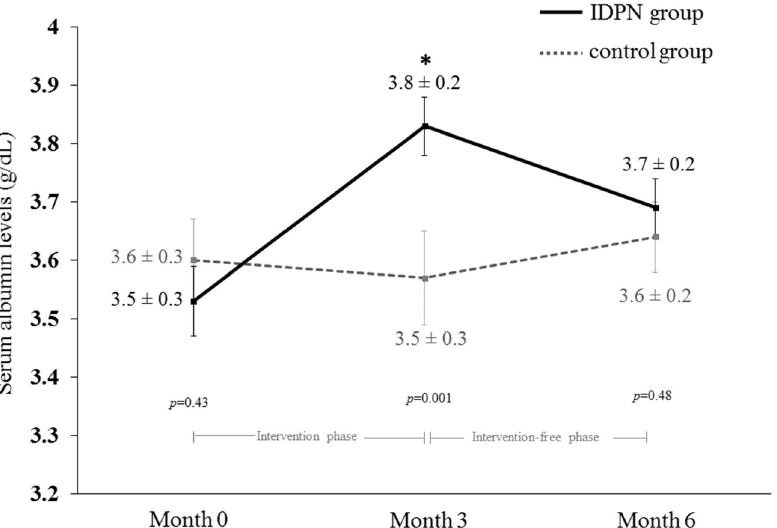
Figure 2. Comparison of serum albumin level as the primary outcome of the study from baseline to the end of study. Data are shown as mean ± SD. p values for between groups comparison. *denotes p < 0.01 between the control and IDPN group at 3 months.